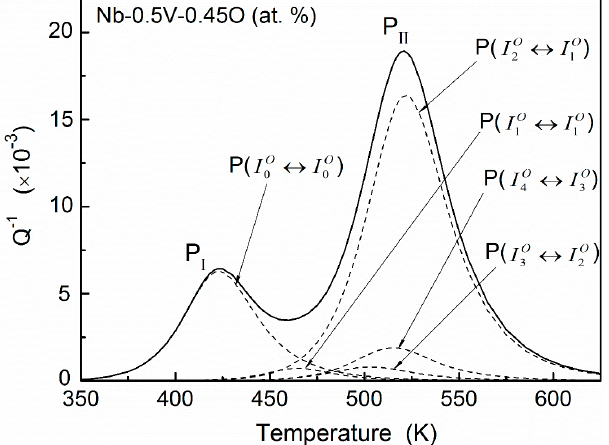
Figure 9. Plots of Q u − 1 m vs. c O u for the fitted elementary peaks in the Nb–0.5V (at. %) alloys: ( a ) P(